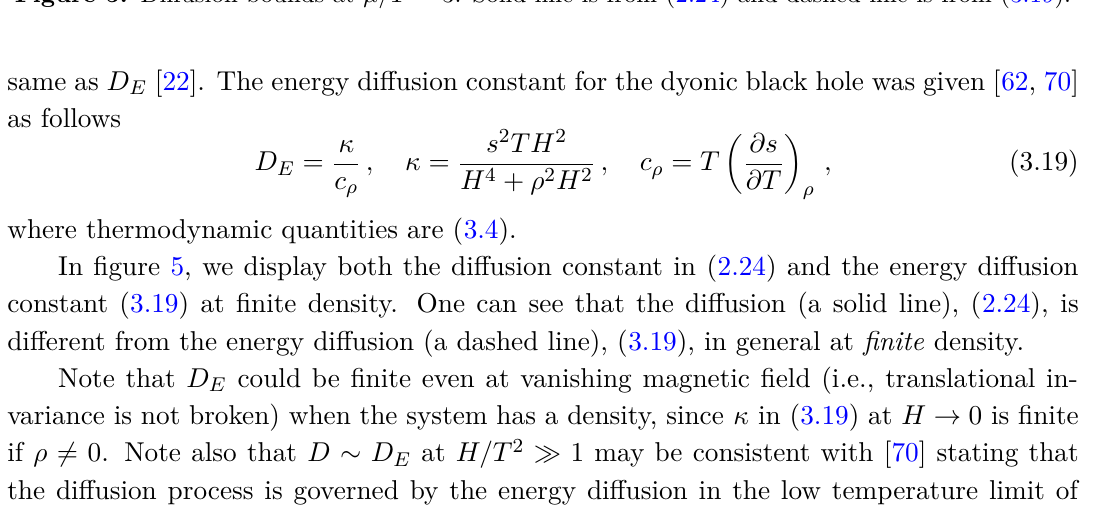
Figure 5. Diffusion bounds at µ/T = 3 . Solid line is from (2.24) and dashed line is from